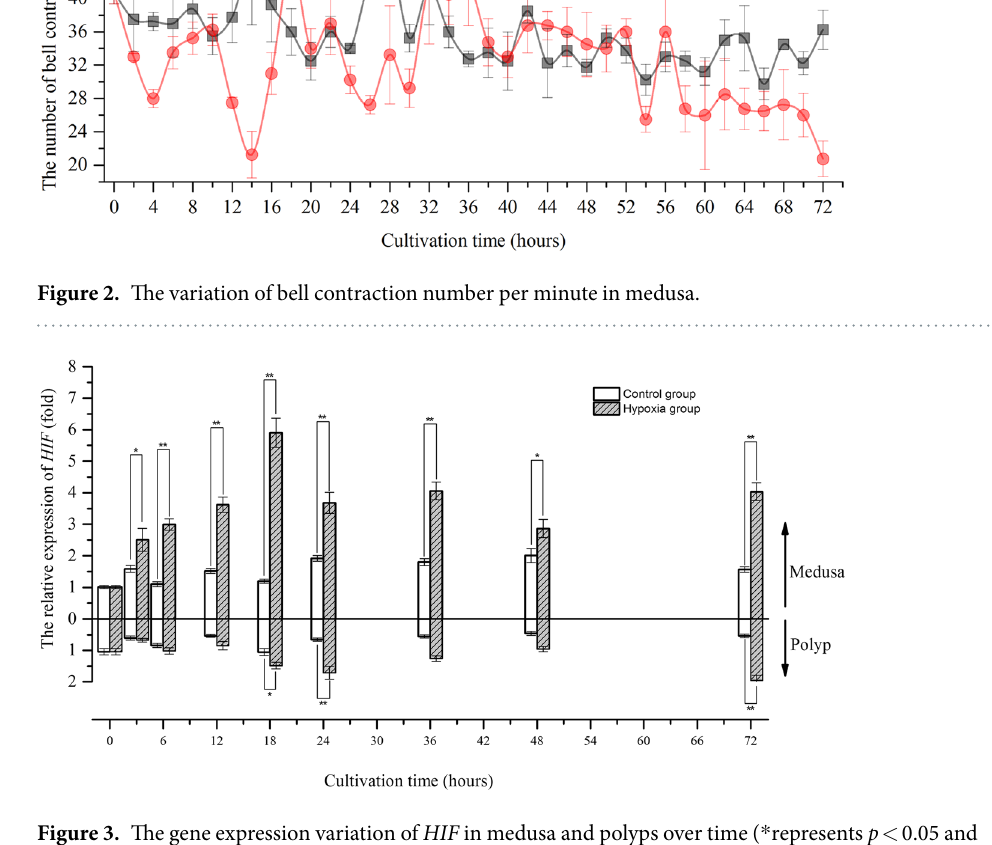
relative expression of HIF in the medusae significantly increased after 3 hours, peaked at 18 hours (approximately 4.92-fold compared with that in the control group, Welch two -sample t-test, p -value < 0.01), and subsequently